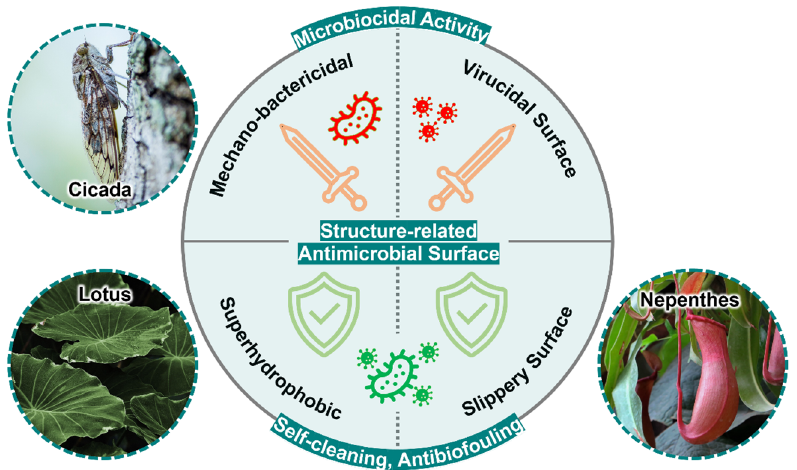
Figure 1. Classification of structure-related antimicrobial surfaces and their natural inspirations. The mechano-bactericidal surface and virucidal surface kill microbes; as superhydrophobic surfaces and slippery surfaces perform self-cleaning and anti-biofouling characteristics to prevent microbial adhesion. These surfaces are inspired by cicada wings, lotuses, and nepenthes, respectively.